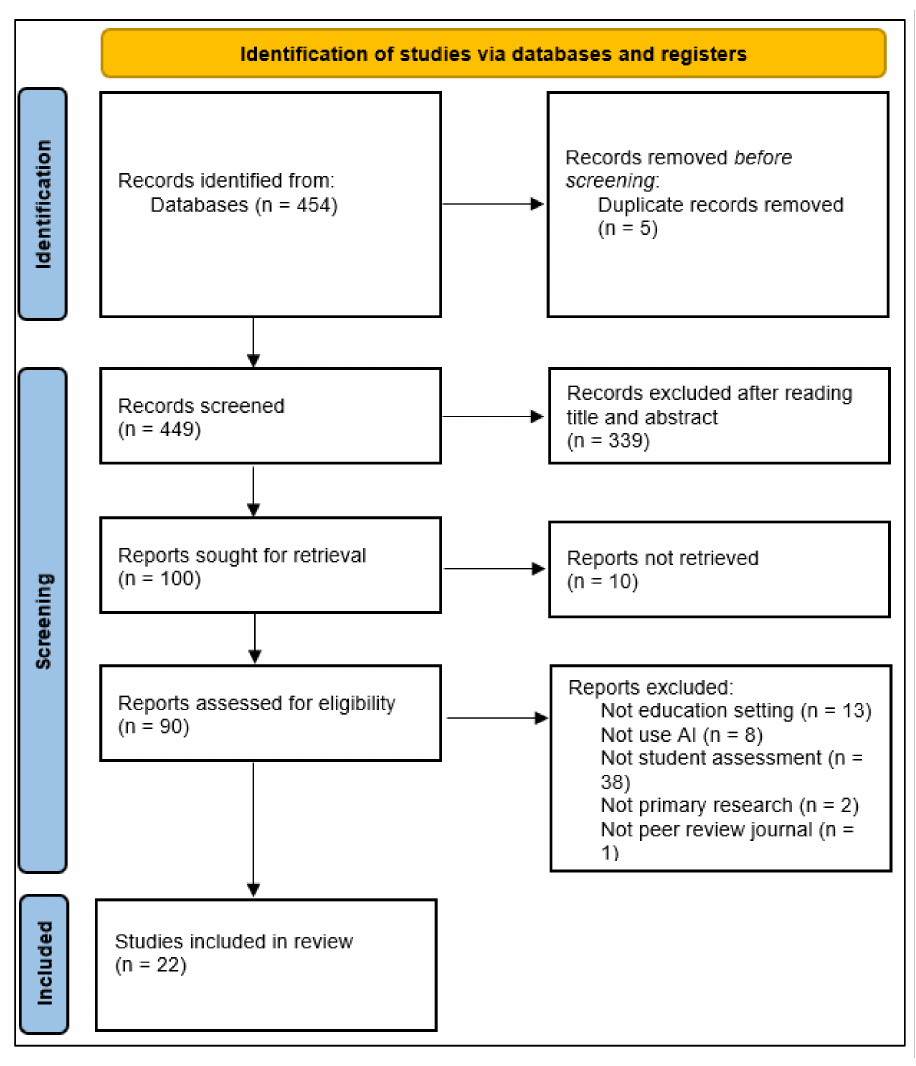
Figure 1. PRISMA diagram [31]. Table 2. Main data of the selected